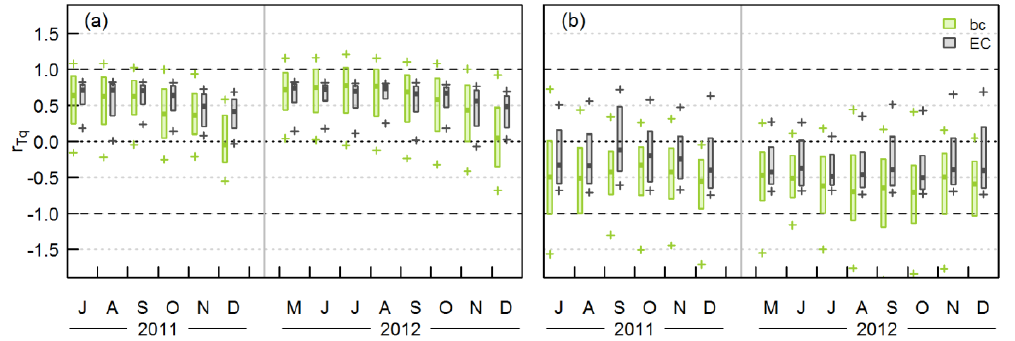
Figure 11. Box plots of r Tq from eddy covariance (EC) and the BLS–MWS bichromatic-correlation method for (a) unstable and (b) stable conditions. Crosses indicate the 10th and 90th percentiles, boxes enclose the inter-quartile range (25th to 75th percentiles) and heavy lines indicate the